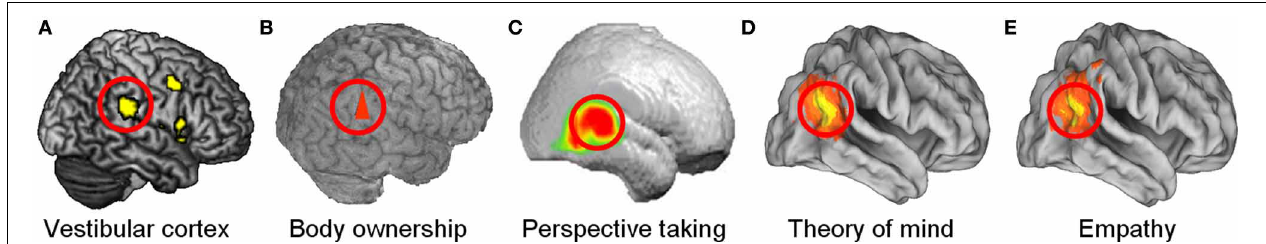
FIGURE 1 | Anatomical overlap between areas involved in vestibular processing, self-processing, and social cognition. (A) Results of a meta-analysis showing brain regions activated by various techniques of vestibular stimulation. Adapted from Lopez et al. (2012). (B) Temporo-parietal cortex where transcranial magnetic stimulation modified